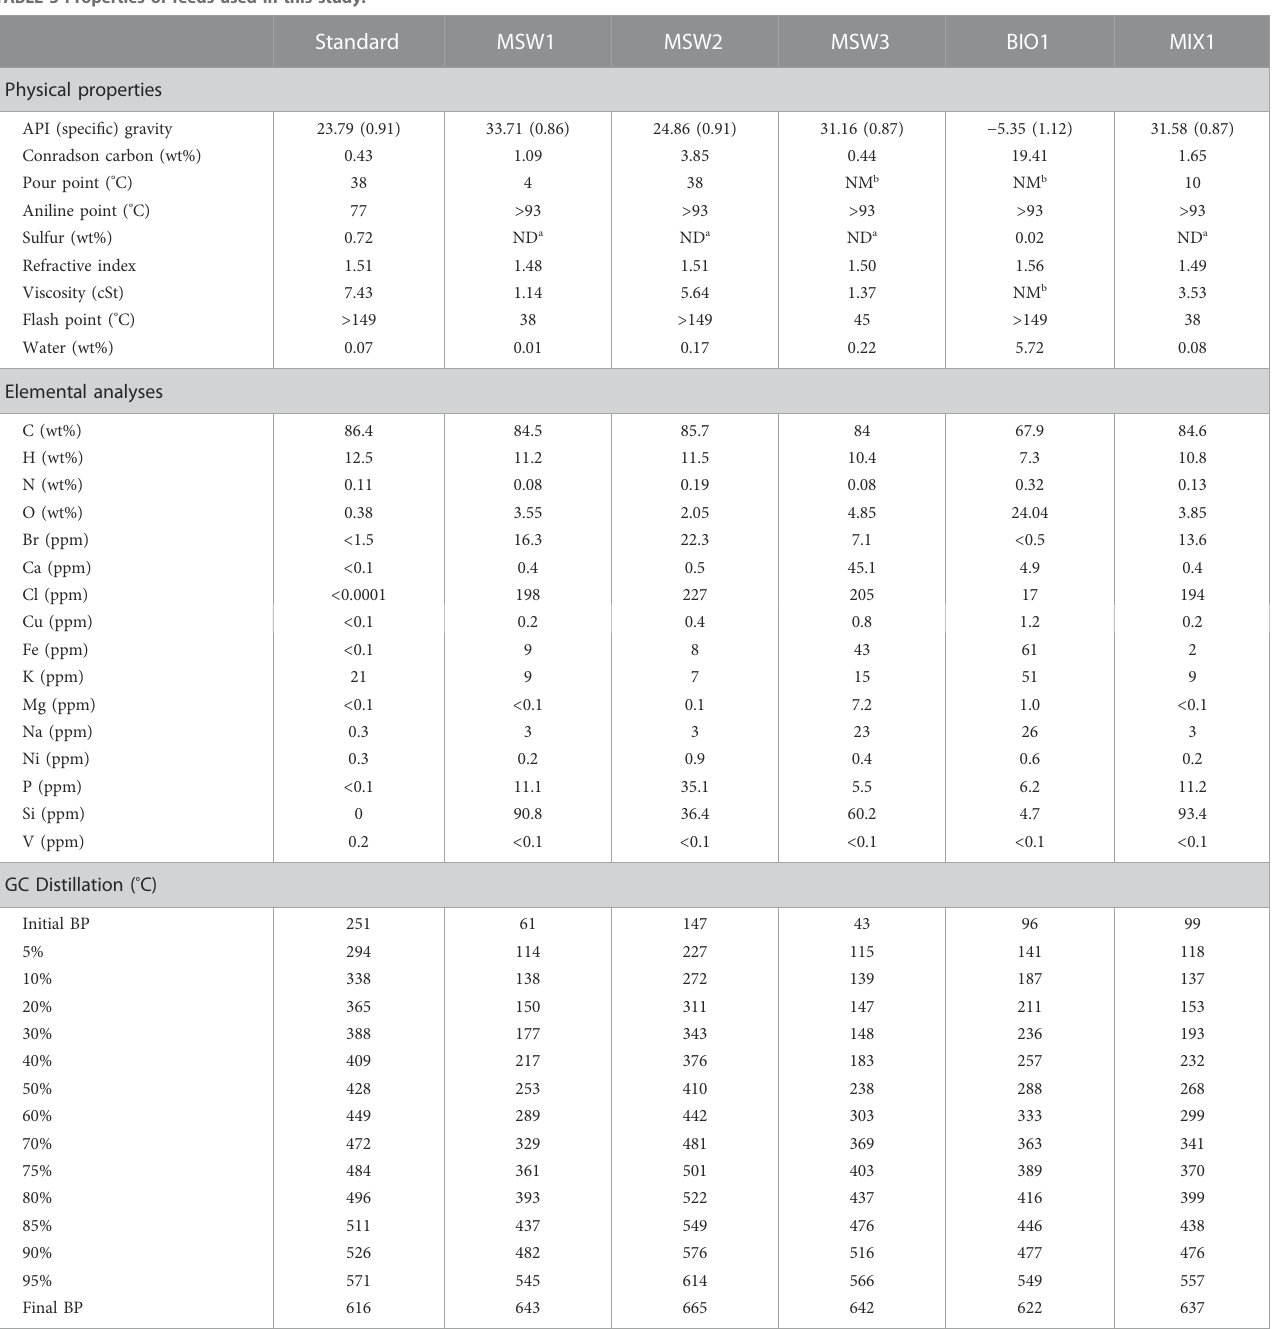
TABLE 3 Properties of feeds used in this